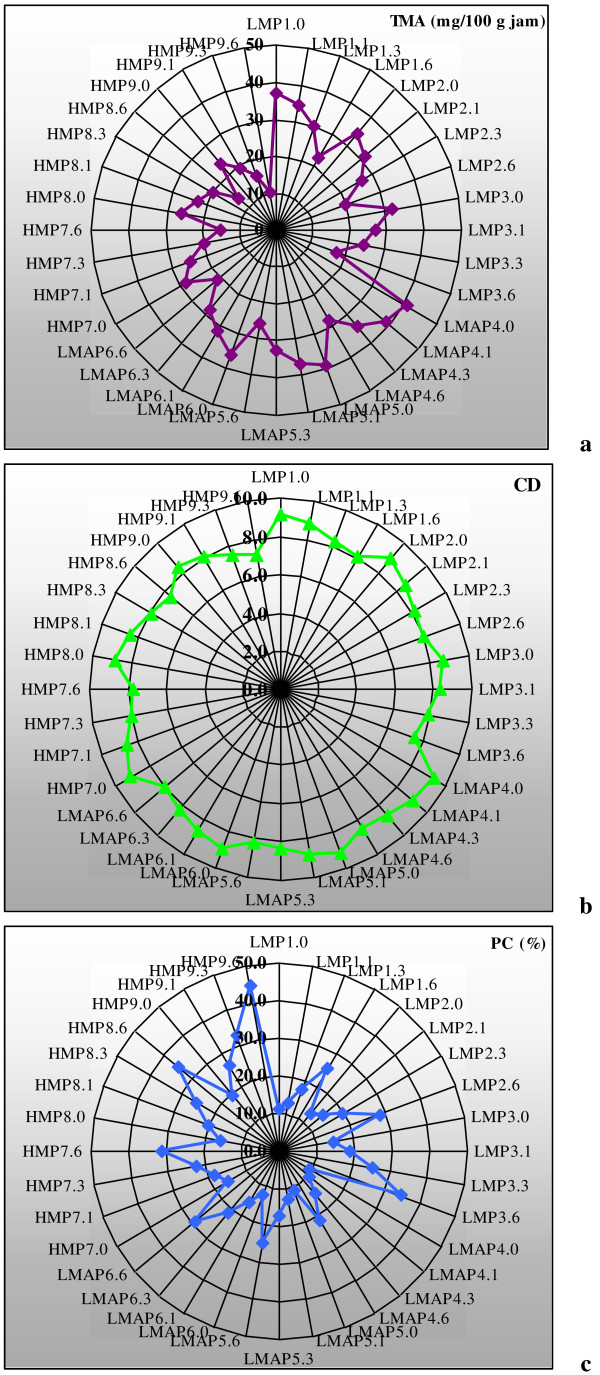
Star representation of TMA (a), CD (b) and PC % (c) variation during jam storage. Legend: LMP1: LMP 1%; LMP2: LMP 0.7%; LMP3: LMP 0.3%; LMAP4: LMAP 1%; LMAP5: LMAP 0.7%; LMAP6: LMAP 0.3%; HMP7: HMP 1%; HMP8: HMP 0.7% and HMP9: HMP 0.3%. In samples labeled as LMP1.0, LMP1.6 and so on, the number after point represents the storage time (e.g. LMP1.0: LMP1 one day post-processing; LMP1.6: LMP1 after 6 months of storage).